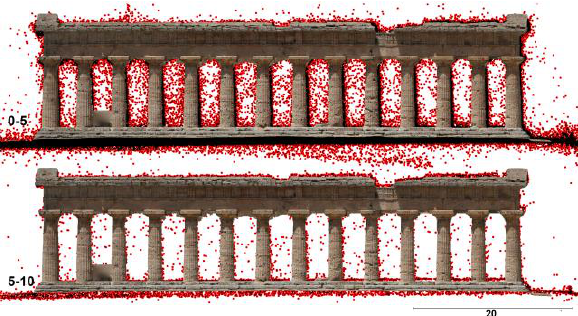
Figure 8. Projection Accuracy filter: on top for values between [0-5], bottom for values between [5-10].